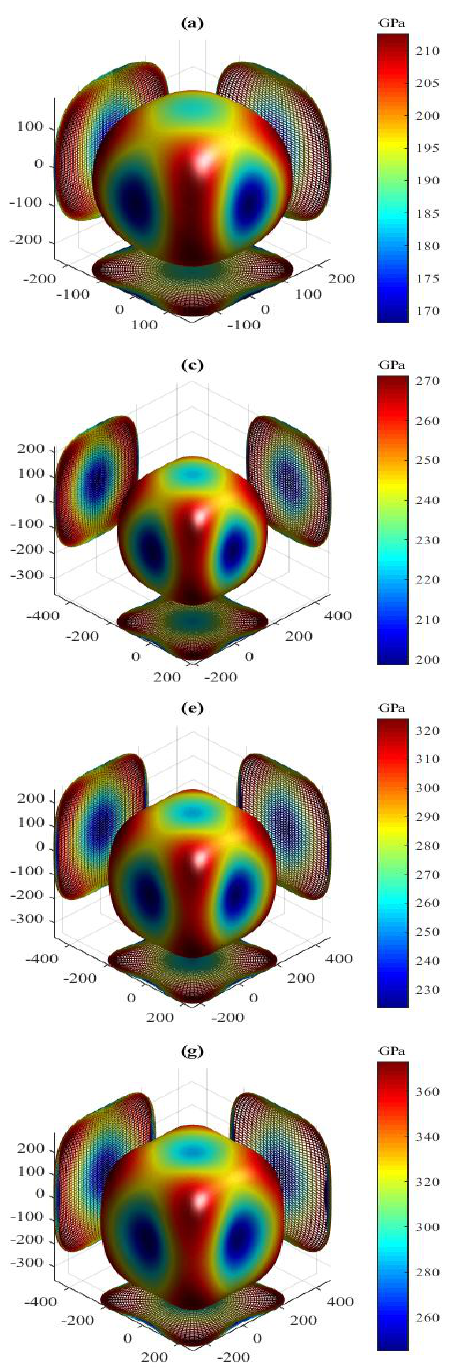
Figure 11. Directional dependence of Young’s modulus for the LPS r-Al 2 Ti under pressure ( a ) 0